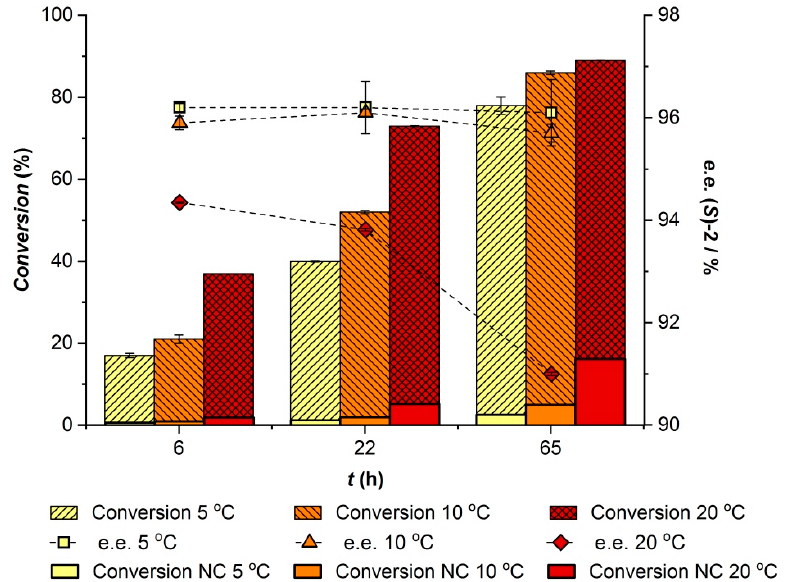
Figure 1. Effect of reaction temperature on the Me HNL-catalyzed hydrocyanation of 100 mM 4-anisaldehyde in a biphasic system using 6.5 equivalents of HCN. Negative control (NC) shows the rate of the unselective background reaction.